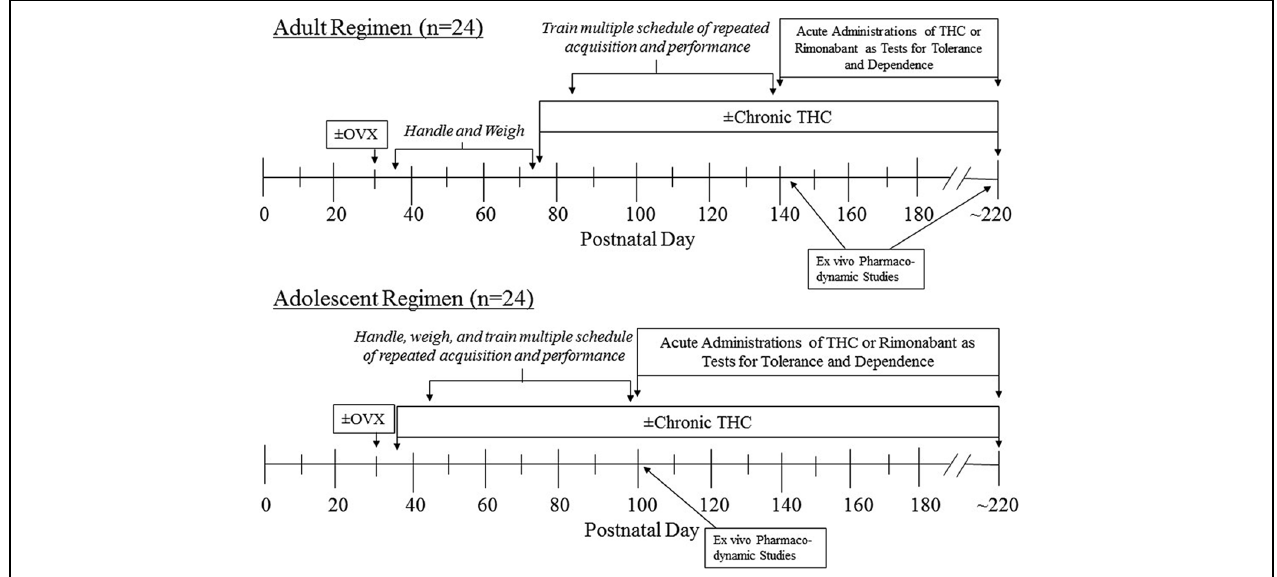
FIGURE 1 | Timeline of manipulations for the two age groups of female subjects that were administered chronic (cid:2) 9 -THC after either ovariectomy (OVX) or a sham operation.